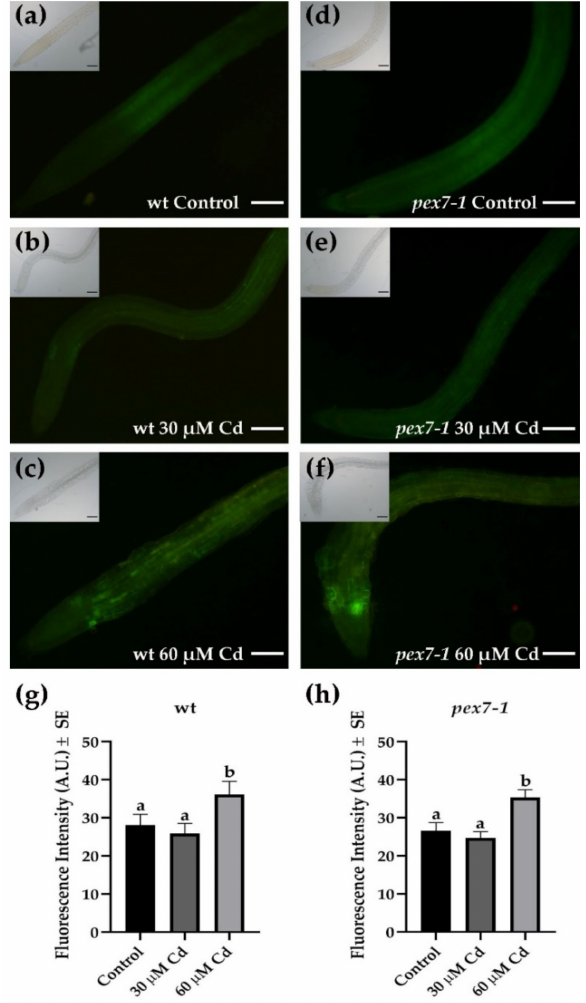
Figure 5. DAF-FM DA epifluorescence analysis showing nitric oxide (NO) signal in the wt ( a – c ) and pex7-1 ( d – f ) roots from seedlings grown in the absence (( a , d ), Control) or in the presence of 30 µ M CdSO 4 (30 µ M Cd) ( b , e ) or 60 µ M CdSO 4 (60 µ M Cd) ( c , f ). Insets in ( a – f ) show the same field under white light. ( g , h ) mean values ( ± SE) from three biological replicates of DAF-FM DA fluorescence intensity measured using ImageJ software (version 1.53c, Wayne Rasband, National Institutes of Health, Bethesda, USA) and expressed in arbitrary units (A.U.s; from 0 to 255). Columns labelled with different letters among treatments show statistical differences for at least p < 0.05 level. Columns labelled with the same letter are not statistically different ( p > 0.05). Bars = 100 µ m. n =